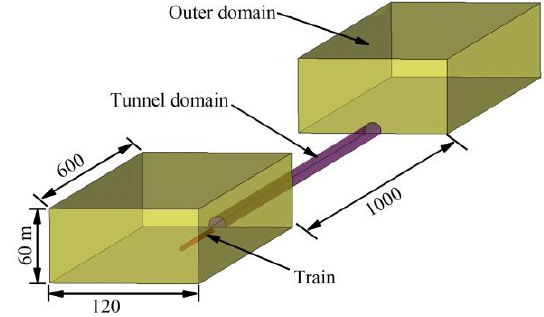
Figure 3. Computational domain (unit: m).